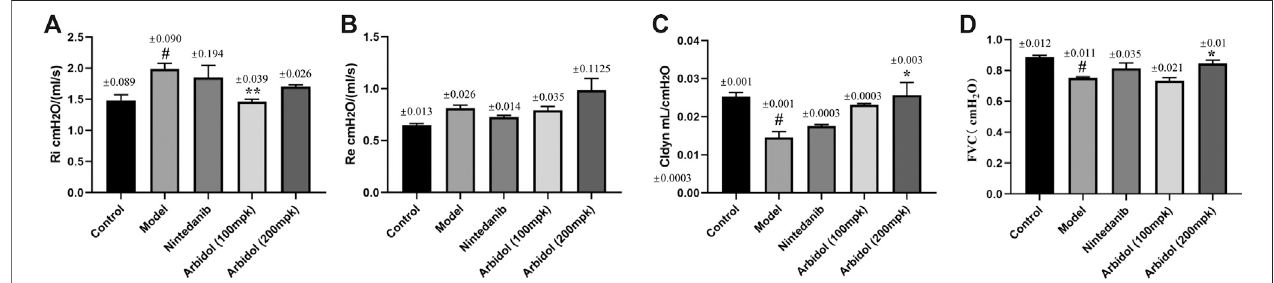
FIGURE2| EffectofarbidolonBLM-inducedpulmonaryfunctionimpairmentinmice.Lungfunction (A) (inspiratoryresistance,RI) (B) (expiratoryresistance,Re) (C) (dynamic lung compliance, Cldyn) and (D) (forced vital capacity, FVC) of the mice in the different groups described above were measured by pulmonary function apparatus. Values are presented as the mean ± SEM (n (cid:1) 5), # p < 0.05, signi fi cantly different from control group; * p < 0.05, ** p < 0.01 signi fi cantly different from model groups.